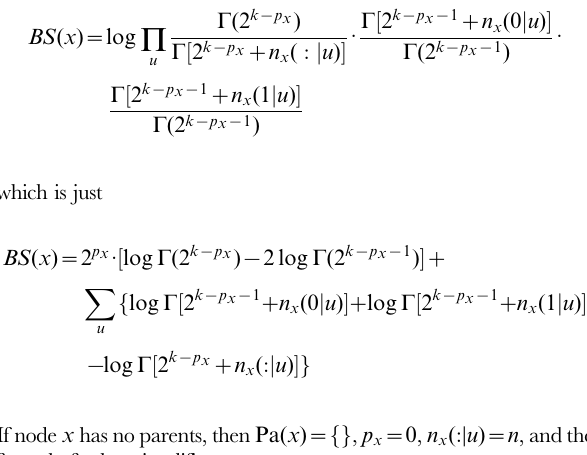
Figure S1 Frequency of the editing statuses. (blue) human subjects with major depression; (cyan) normal human controls; (orange) transacted rats; (red) normal rat controls. Figure S2 Clustering of the five editing sites using Dice distance. ( a ) human; ( b ) rat.